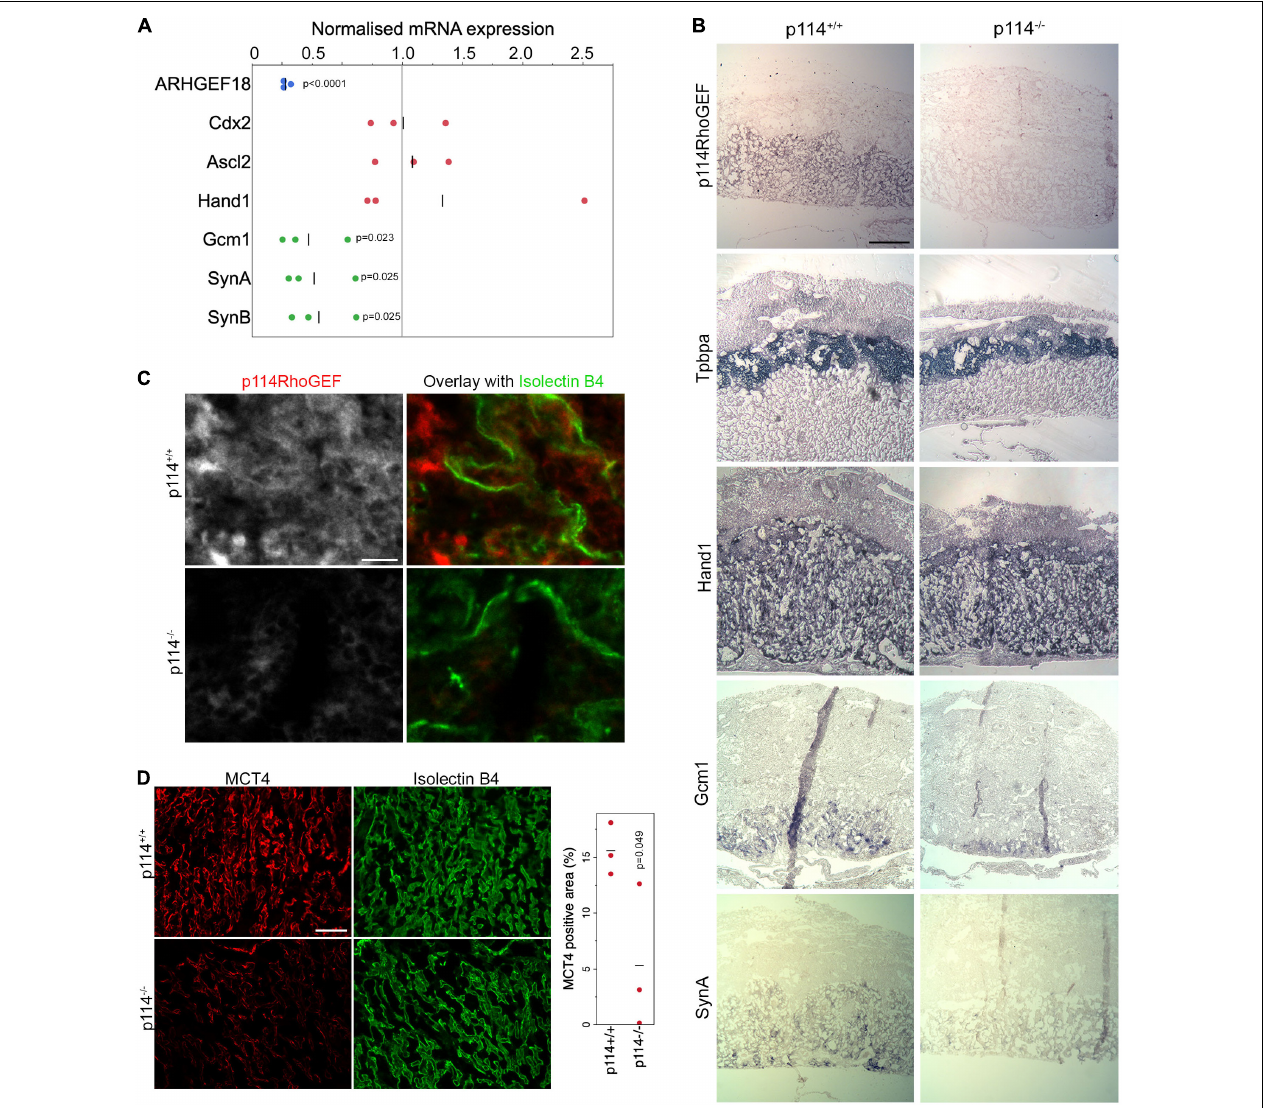
FIGURE 2 | p114RhoGEF is required for labyrinth syncytiotrophoblast differentiation. (A) RNA expression analysis of p114RhoGEF and markers for stem cells (Cdx2), spongiotrophoblasts (Ascl2), trophoblast giant cells (Hand1), and syncytiotrophoblasts (Gcm1, SynA, and SunB). Data were normalized to wild type controls in each litter. Shown are data points, means and p -values derived from t -tests (B) E12.5 control and p114 − / − placenta cryosections (12 µ m) were analyzed by in situ hybridization. p114RhoGEF was preferentially expressed in the labyrinth layer and expression was lost in knockout placentas. Of the trophoblast markers, only the syncytiotrophoblast markers Gcm1 and SynA were reduced in p114 − placentas. Indicated are the main layers of the placenta: the maternal decidua basalis (DB) and the embryo-derived junctional zone (JZ) and labyrinth (L). (C) Immunofluorescence analysis of p114RhoGEF expression in placenta cryosections in comparison to Isolectin B4 staining of endothelial cells. Note, p114RhoGEF staining, which is lost in knockout placentas, overlaps with but is not restricted to endothelial cells. (D) Staining of MCT4 and Isolectin B4 in placenta cryosections reveals a disorganized appearance of endothelia-lined blood vessels and a reduced expression of the syncytiotrophoblast marker MCT4. The graph shows a quantification of MCT4-positive areas, indicating syncytiotrophoblasts, in placenta sections derived from 3 different embryos (the p -value is based on a t -est). Bars: (B) , 0.5 mm; (C) , 50 µ m; (D) , 0.2